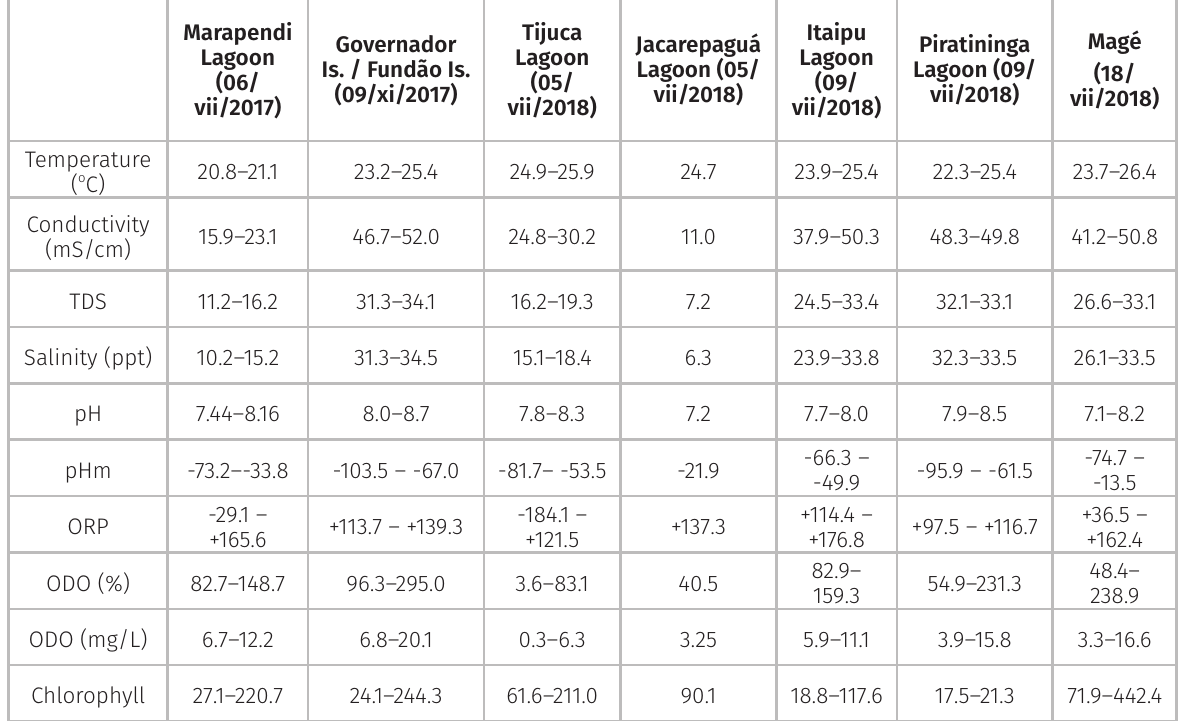
Table I. Environmental factors measured in visited sites. TDS = Total Dissolved Solids. ORP = Oxidation Reduction Potential. ODO = Optical Dissolved